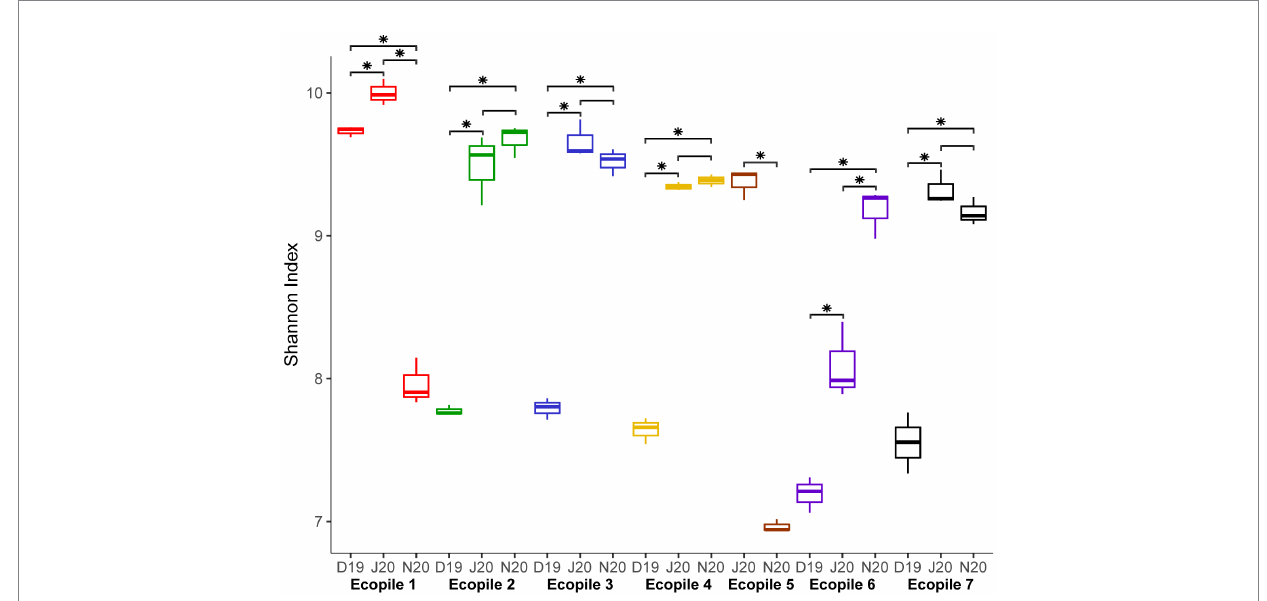
FIGURE 1 Boxplot representing the bacterial Shannon index values for each timepoint and Ecopile. Boxplots contain the Shannon index values of the three replicates of each sample. Differences between Shannon index values at the different timepoints were assessed with the Kruskal-Wallis test. Asterisks represent the significance at a p adjusted-value ≤ 0.05. Colors of boxplots according to the different Ecopiles.